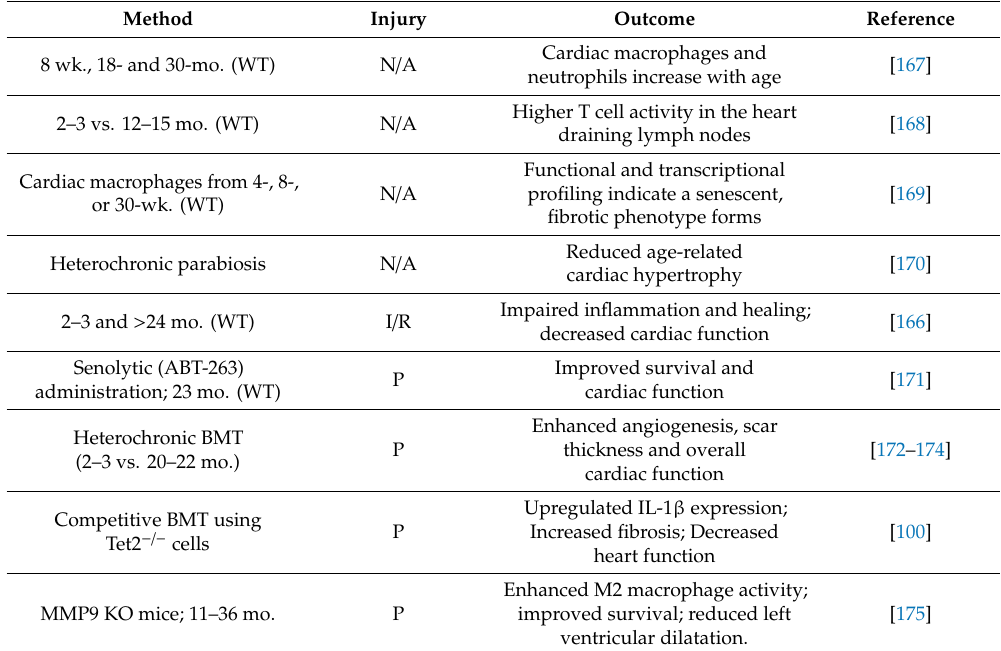
Table 1. A brief summary of the e ff ect of aging on cardiac immune cell infiltrate or repair